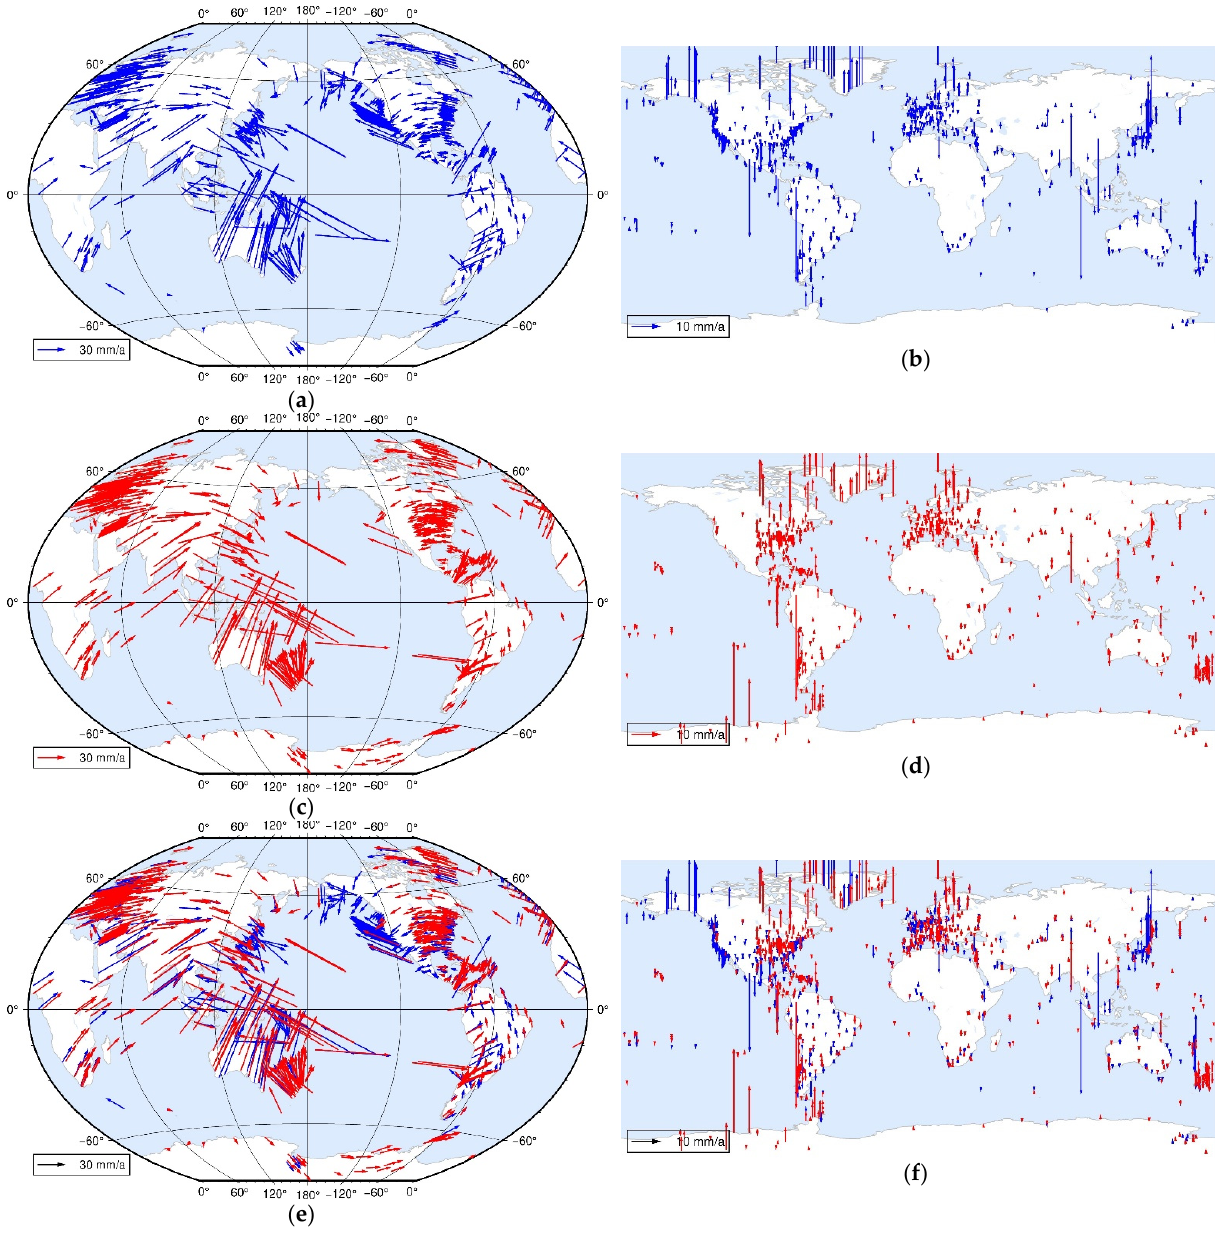
Figure 17. Comparison of the ITRF2014 and GGV2020 global GNSS velocity fields. ( a ) ITRF2014 horizontal velocity field; ( b ) ITRF2014 vertical velocity field; ( c ) GGV2020 horizontal velocity field; ( d ) GGV2020 vertical velocity field; ( e ) ITRF14 and GGV2020 horizontal merging velocity field; ( f ) ITRF14 and GGV2020 vertical merging velocity field. Figure 18 shows the difference in the same sites’ velocity fields between ITRF2014 and GGV2020. The velocity differences of the two products in three directions were less than 2 mm/a, and the RMS of differences were 1.73, 1.18, and 1.83 mm/a, respectively. The difference between the velocity fields obeys normal distribution. The above analysis re- sults showed that the two products are similar, but there is still a difference of about 1–2 mm/a on the whole. The specific reasons are as follows: 1.